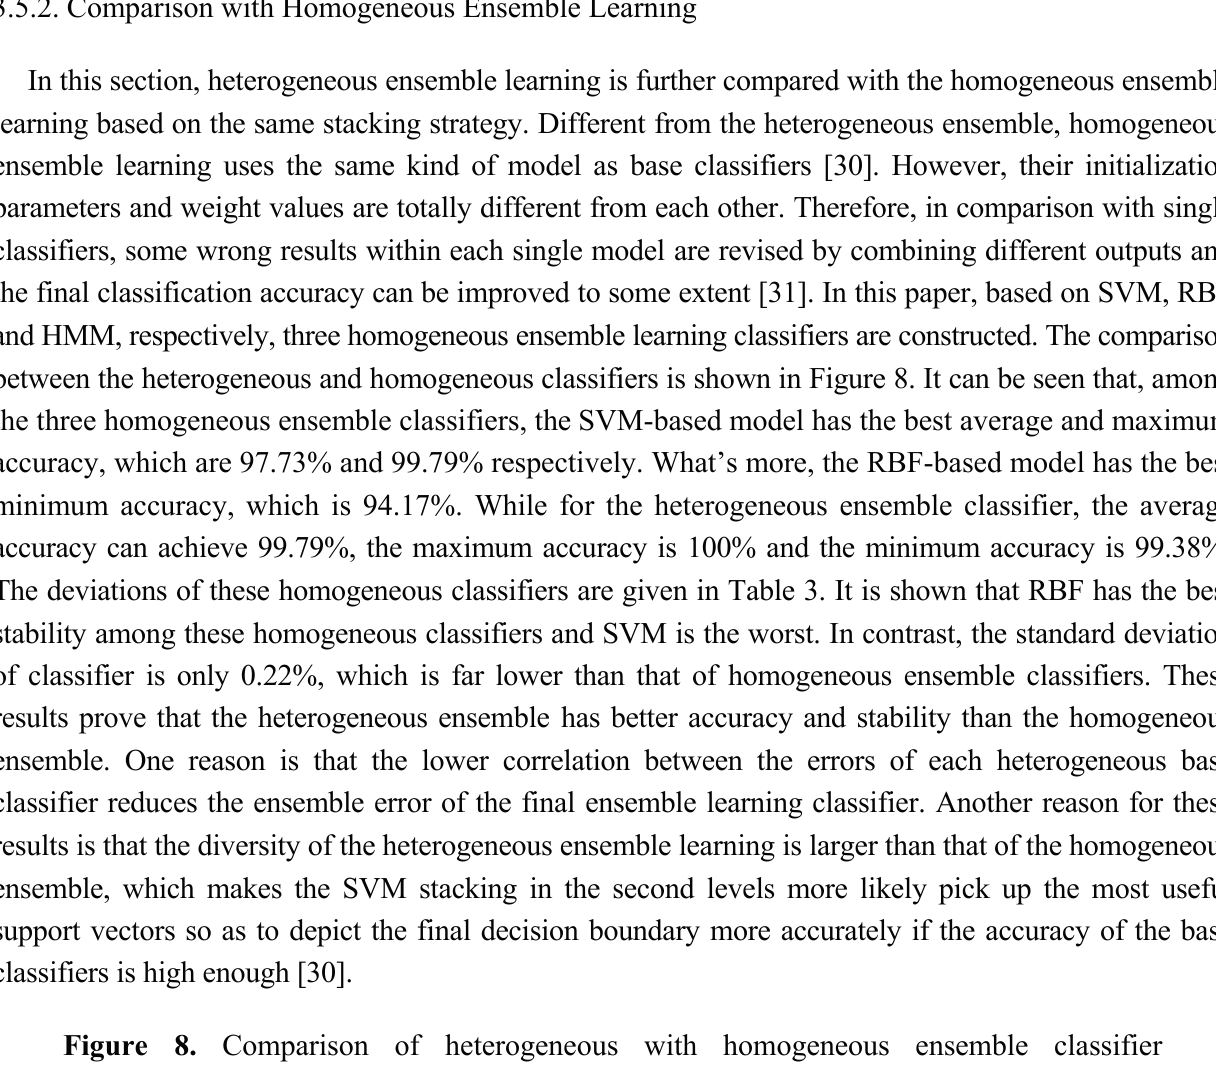
Figure 8. Comparison of heterogeneous with homogeneous ensemble classifier (Het-s—heterogeneous ensemble with stacking, SVM-s—SVM homogeneous ensemble with stacking, HMM-s—HMM homogeneous ensemble with stacking; RBF-s—RBF homogeneous ensemble with